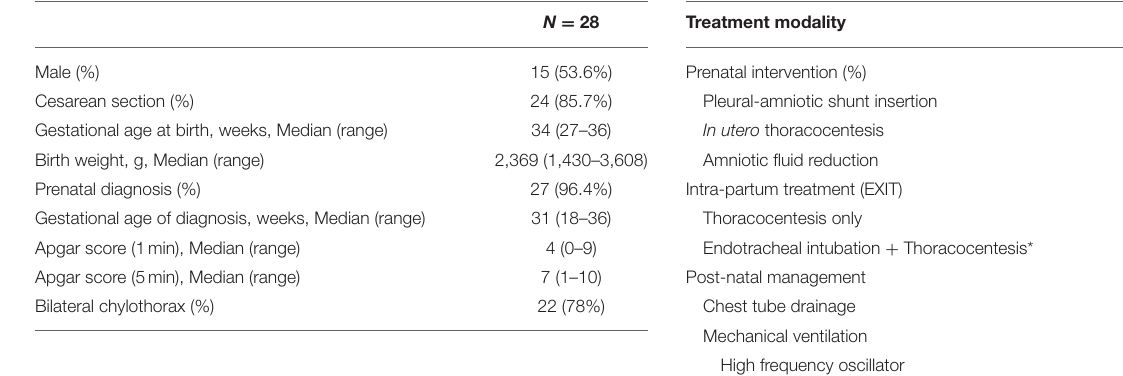
TABLE 1 | Demographic data and clinical characteristics. TABLE 2 | Prenatal, intra-partum, and post-natal